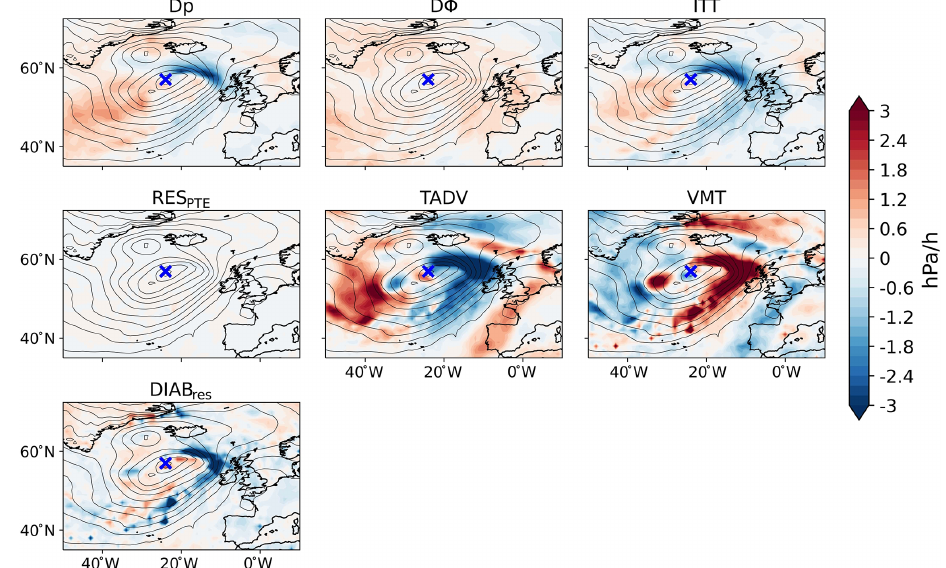
Figure 10. Illustration of the PTE terms in the 2.5km EC simulation with one-moment cloud microphysics. The figure is for 23 September 2016 at 12:00. The cyclone position as given by the minimum mean sea level pressure is marked by the blue